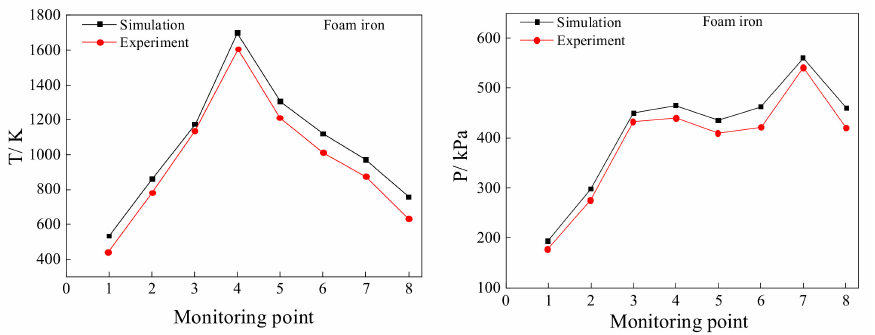
Figure 4. Maximum temperature and overpressure at each monitoring point with foam iron installed in the